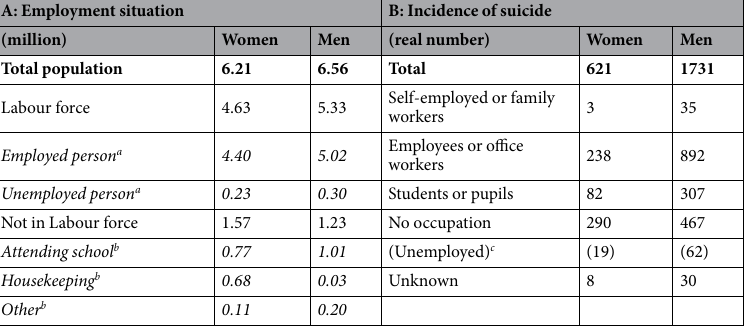
Table 4. Employment (A) and suicide rate (B) among population aged 20–29 years in Japan, 2015. Under “A: Employment situation”, the population is divided into “Labour force” and “Not in labour force”. “Labour force” consists of “Employed person” and “Unemployed person” and “Not in labour force” includes “Attending school”, “Housekeeping”, and “Other”. Under “B: Incidence of suicide”, suicide victims are divided into five groups: “Self-employed or family workers”, “Employees or office workers”, “Students or pupils”, “No occupation”, and “Unknown”. In B, “Unemployed” is treated as a part of “No occupation”. a Labour force. b Not in Labour force. c No